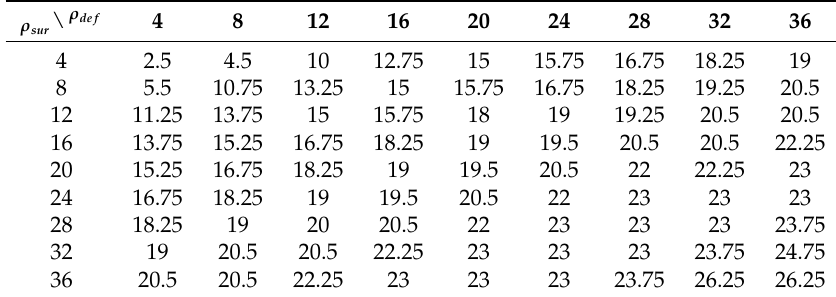
Table 7. Optimal BESS size energy capacity (MWh) for a 15 year-project lifetime; optimal power capacity (MW) is the same as Table 5; penalties are in